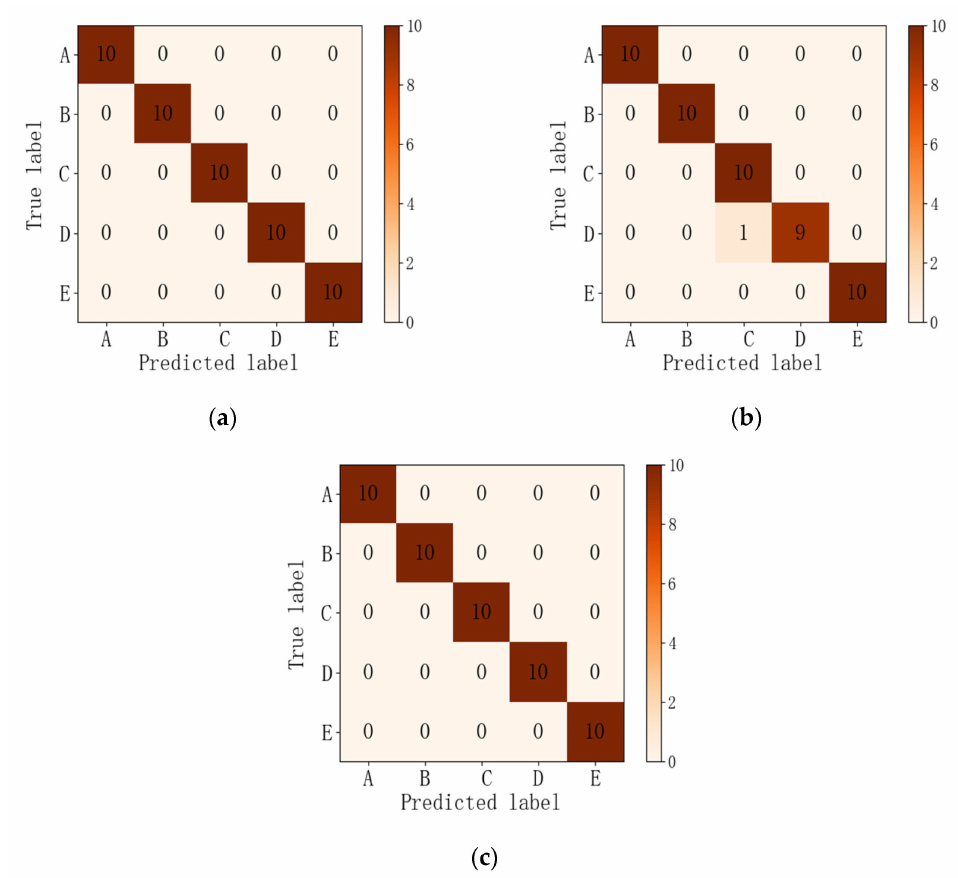
Figure 11. Confusion matrix for vehicle speed identification results: ( a ) Test results of acceleration samples; ( b ) Test results of speed sample; ( c ) Test results of displacement